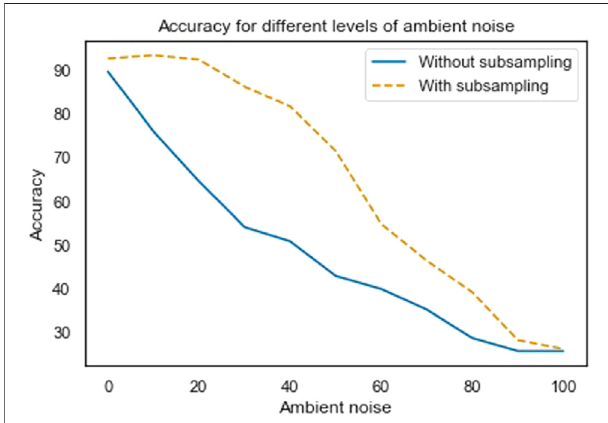
FIGURE 9 | For eachlevel ofambientnoise, classi fi cation is performed with standard stable ranks resulting from point clouds without subsampling (solid line) and with subsampling (dashed line) and classi fi cation accuracies are reported.